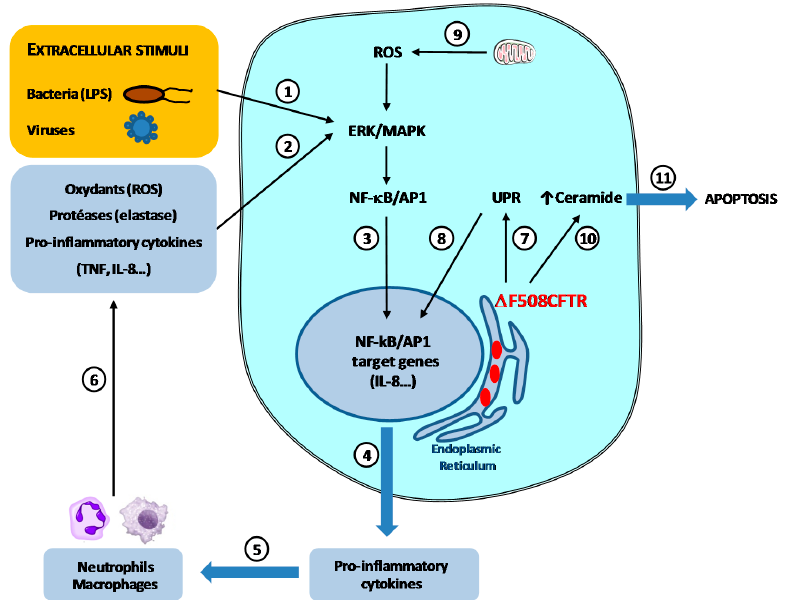
Figure 2. Extracellular and intracellular triggers of inflammation in CF airways cells. Pathogens,